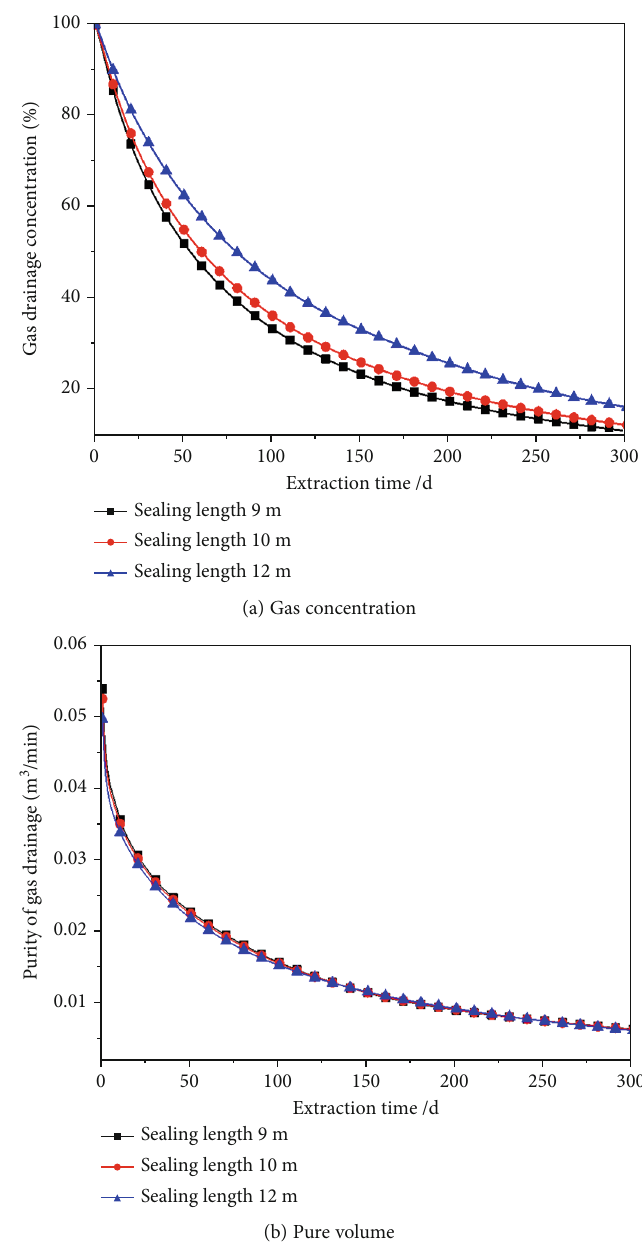
Figure 9: Variation of gas extraction concentration and pure volume with sealing